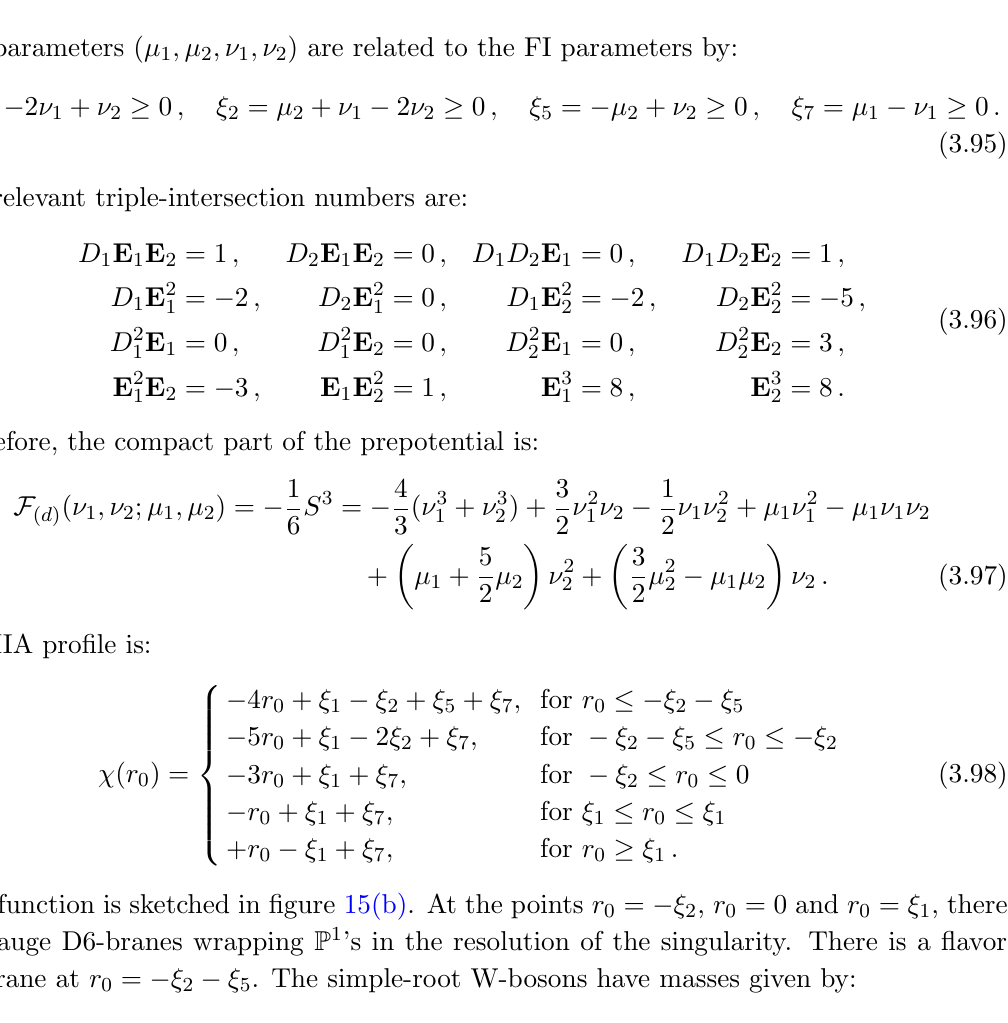
Figure 15 . Resolution (d) of the E 22 ; 3 2 singularity and its vertical